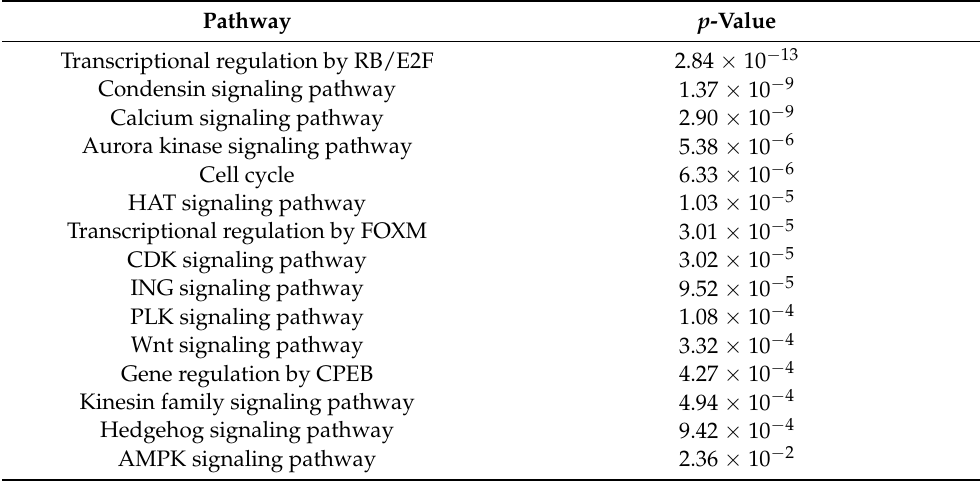
Table 1. The top 15 pathways were regulated by preventive administration of GTE in obese zebrafish ( p <